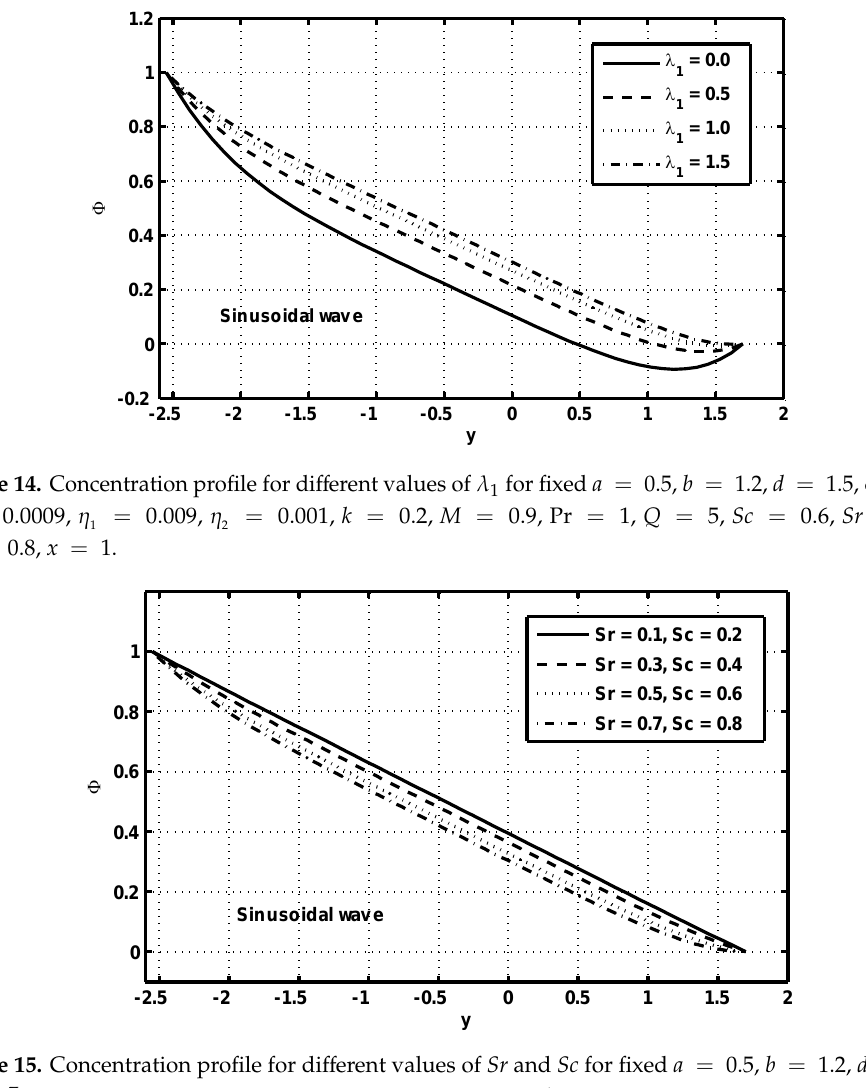
ϕ = π , γ = 0.0009, η 4